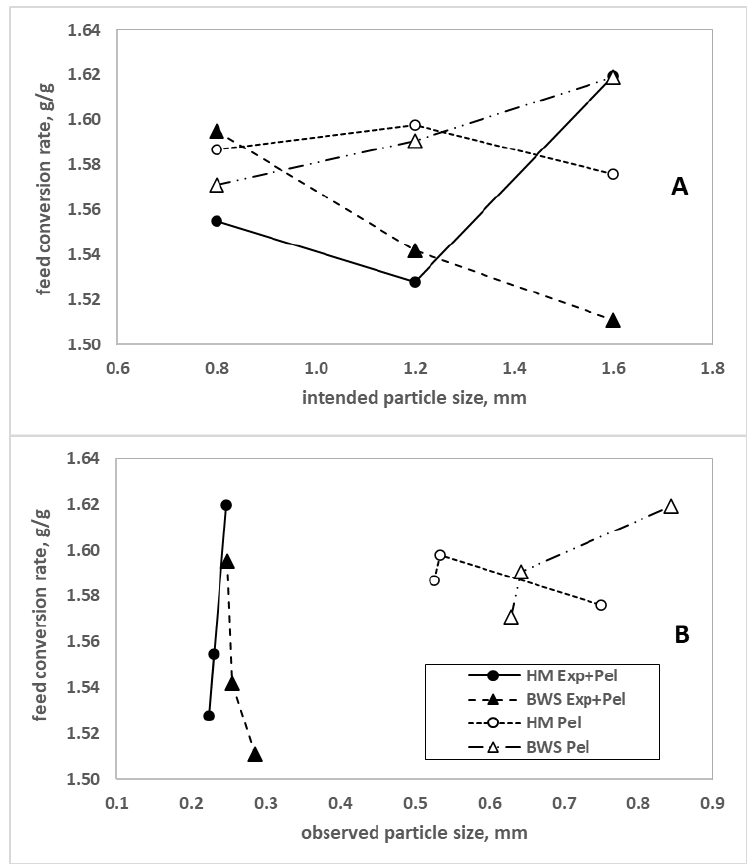
Figure 1. Comparison between intended and observed particle sizes. ( A ) Intended particle sizes are 0.8, 1.2 and 1.6 mm. ( B ) The particle sizes observed after sampling in the feeder, using wet-sieve analyses, representing the compound feed offered to the birds. Each line corresponds to all of the processing steps. HM: hammer mill; RM: roller mill; Exp: expander; Pel: pelleting.